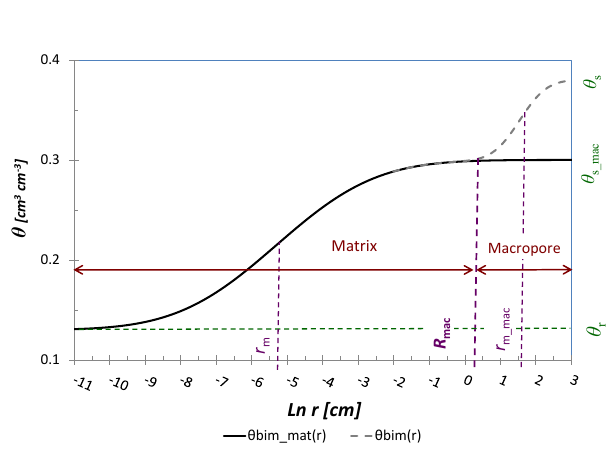
Figure 1. A typical Kosugi θ bim (r) (Eq. 10a) and θ bim_mat (r) (Eq. 10b) with the matrix and macropore domains and the positions of θ s , θ s_mac , θ r , r m , r m_mac , and R mac